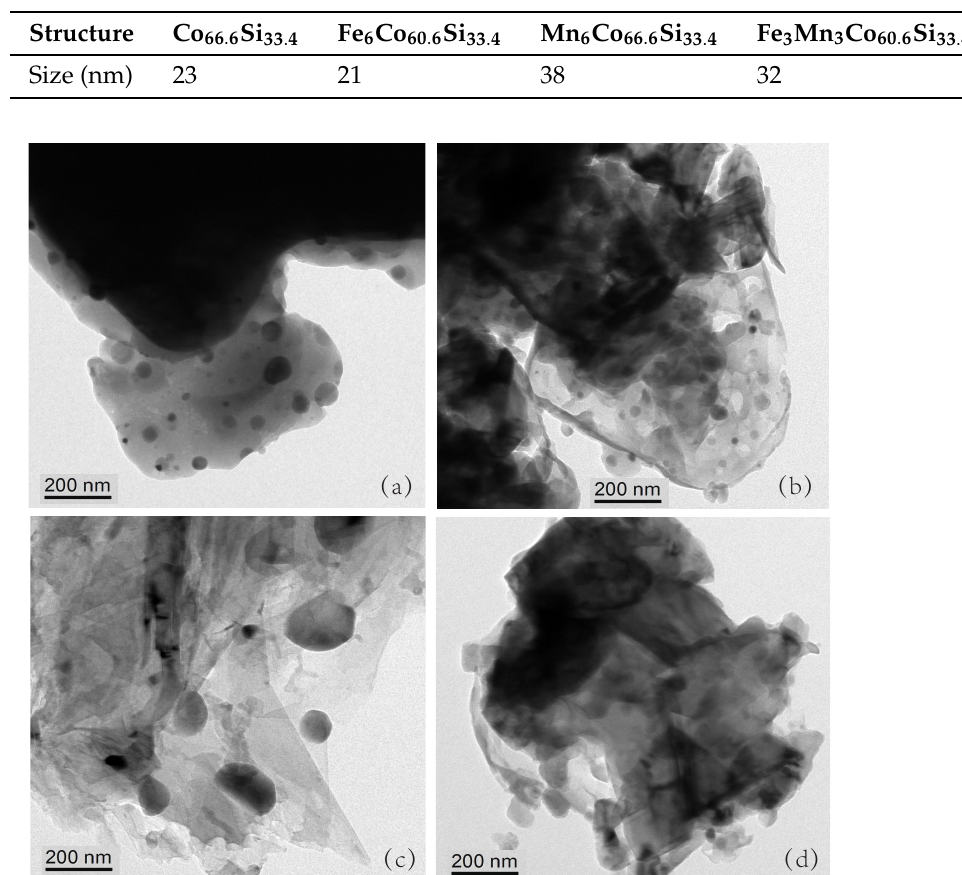
Table 2. Average grain size by testing of as-prepared Co 66.6 Si 33.4 , Co 60.6 X 6 Si 33.4 , (X = Fe, Mn), and